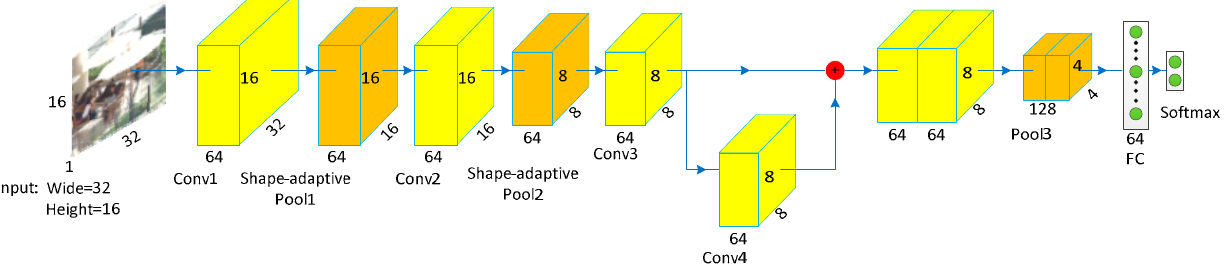
Figure 6. Example diagram with input 32 × 16 CU.